Question: According to the figure, is the described quantity increasing or decreasing?
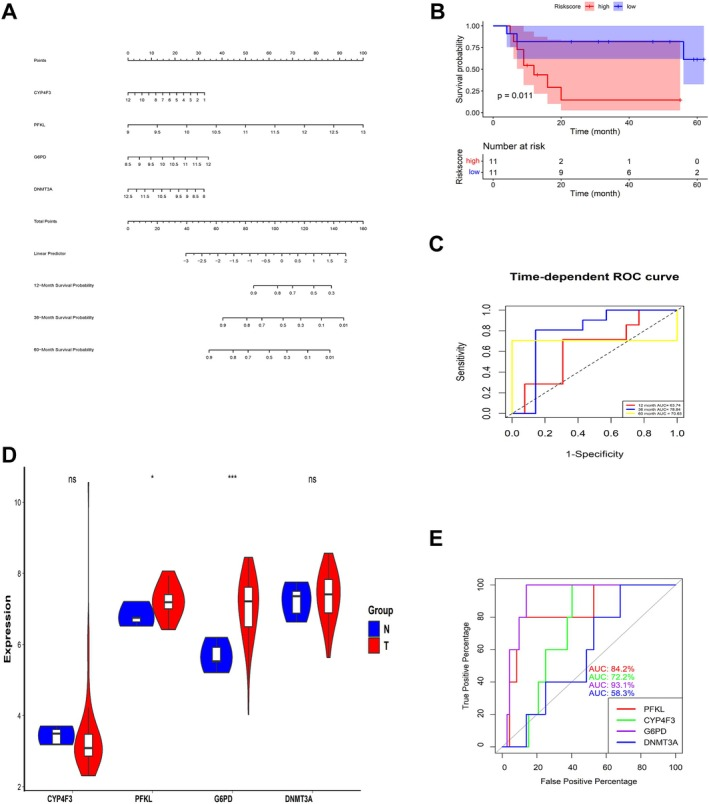
Answer: increasing